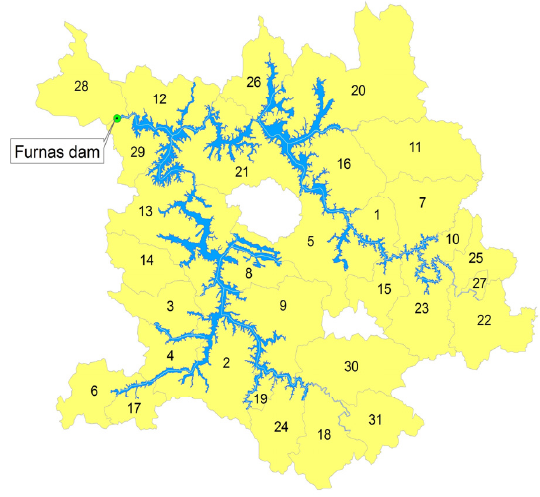
Figure 3. Municipalities with lands flooded by Furnas reservoir All spatial analyses were performed in ArcGIS® version 10.3. First, the coordinates of Furnas reservoir’s spillway (46.3181° W, 20.6697° S) were obtained from Google Earth and used to create a point feature. The upstream portion of the Paraná basin hydrography digital dataset 2 , provided by ANA, the